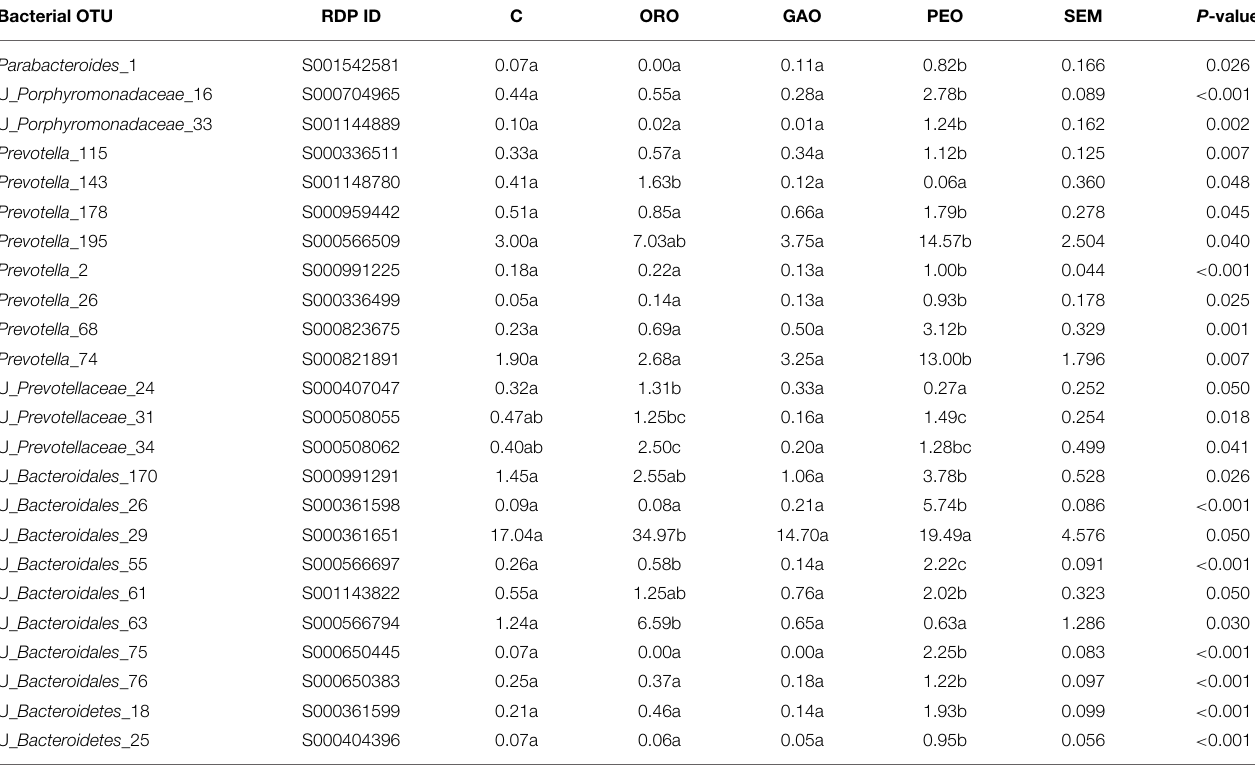
TABLE 3 | Effects of essential oils on populations of ruminal bacteria in the phylum Bacteroidetes and Spirochaetes [only the OTUs with significant ( P ≤ 0 . 05 ) changes in relative abundance are shown]. Bacterial OTU